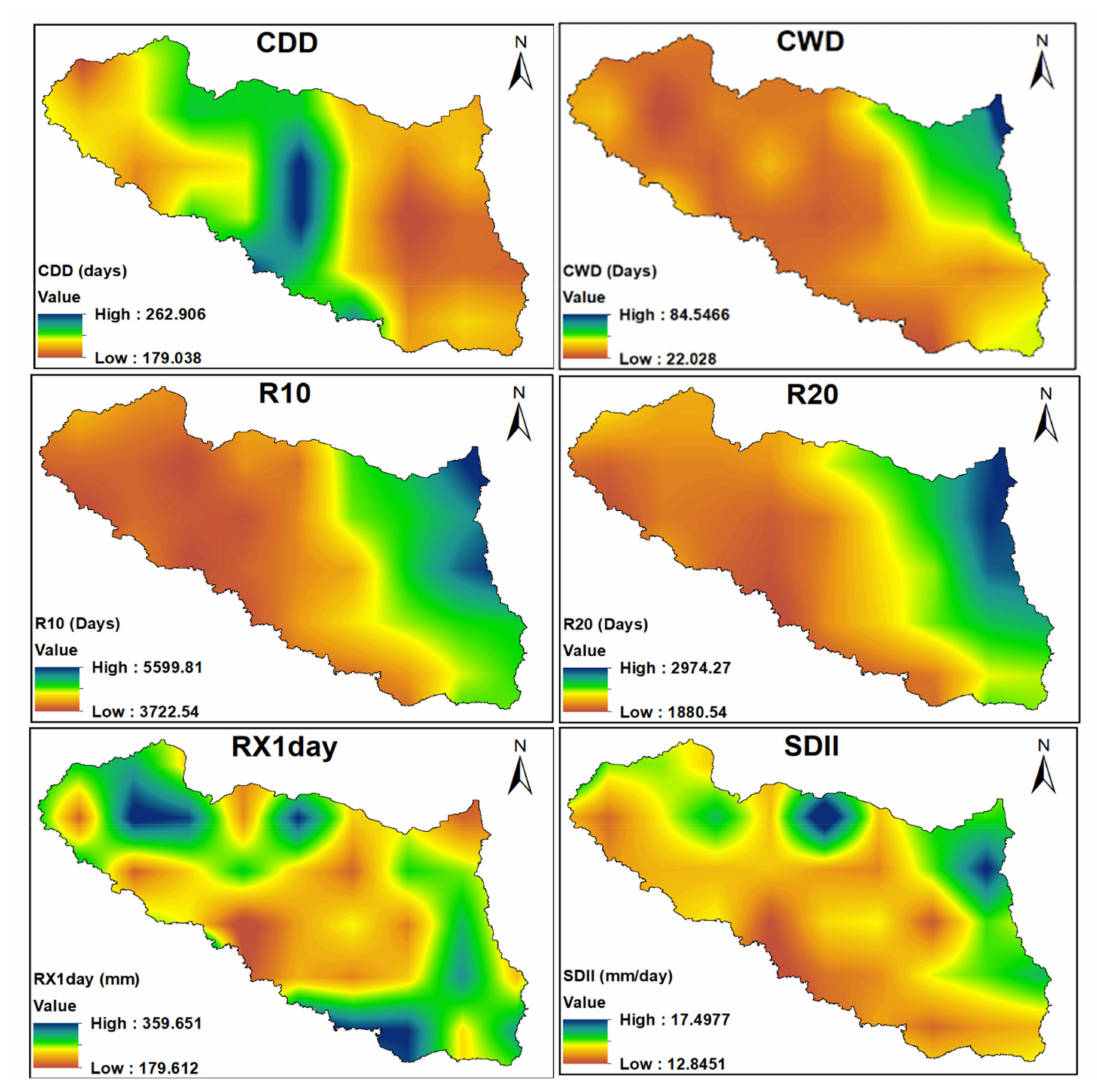
Figure 5. Spatial variability of extreme precipitation indices over the RRB during